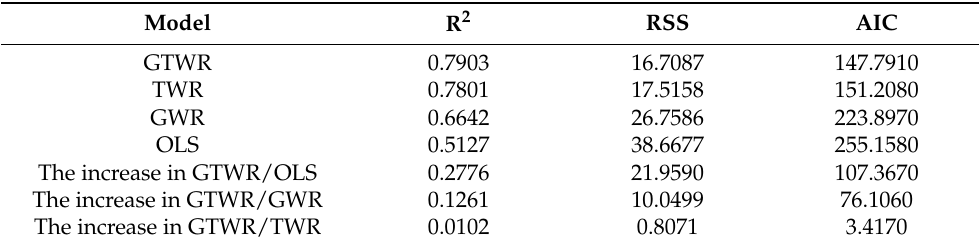
Table 8. Statistics of goodness of fit of different